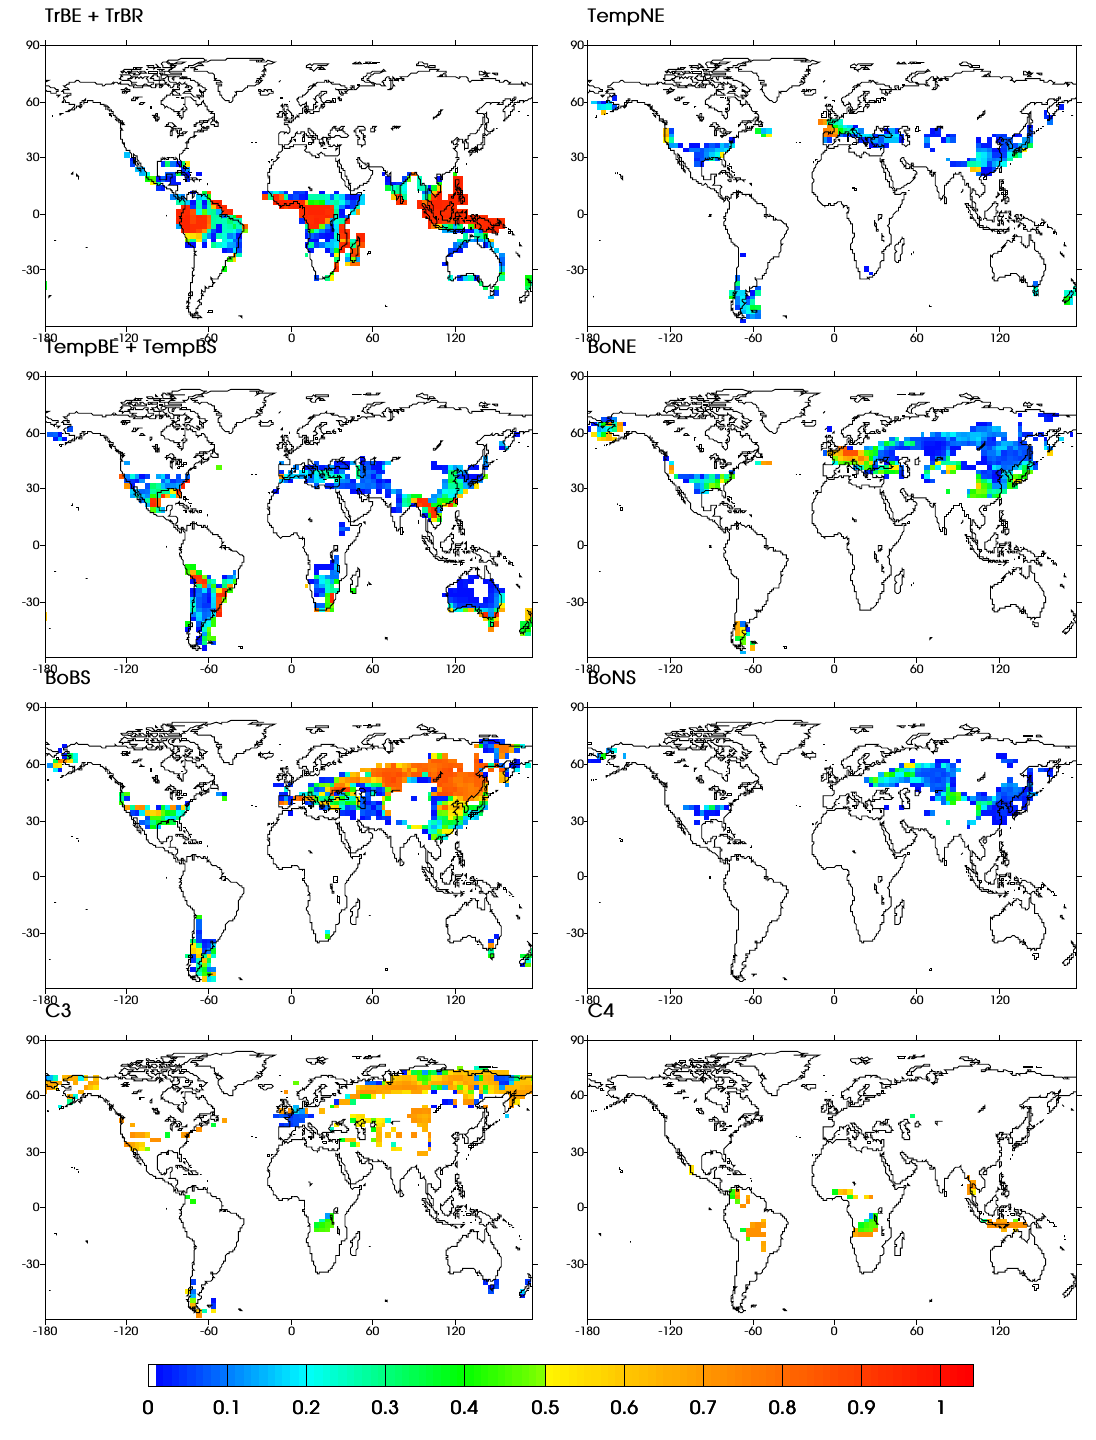
Fig. 9. Fraction of vegetation (annual maximum, in % of grid-cell) simulated by ORCHIDEE in LGMP (LGM climate and modern CO 2 for photosynthesis). Abbreviations: see Table